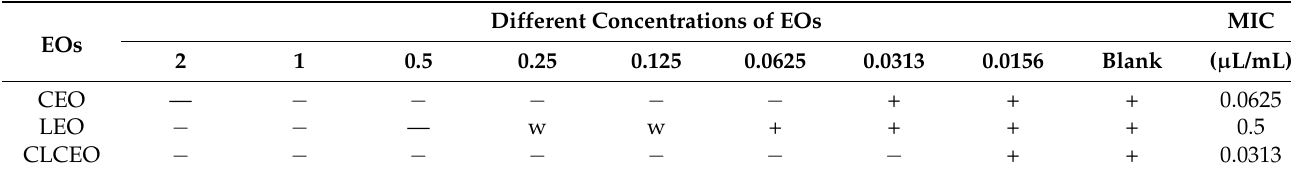
Table 1. Growth of strain YQM treated with different concentrations of CLCEO.